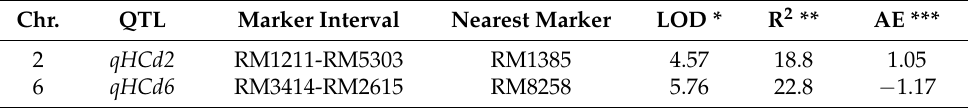
Table 2. Positions and effects of putative QTLs for high Cd concentration in rice straw. Chr. QTL